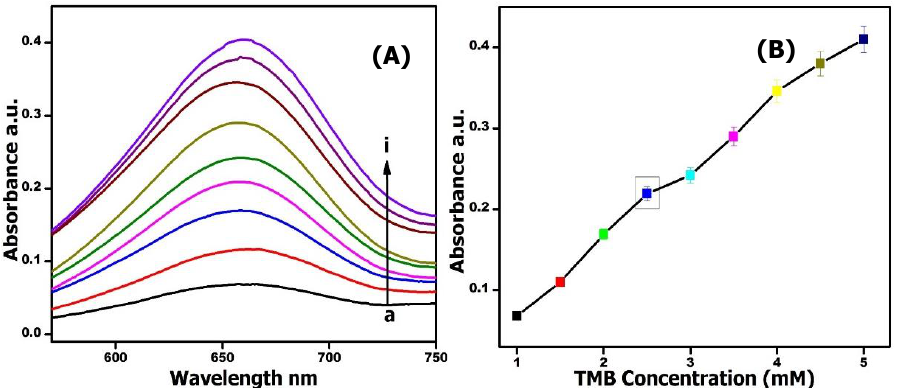
Figure 10. ( A ) Optimization of varying concentrations of TMB: (a) 1 mM (b) 1.5 mM (c) 2 mM (d) 2.5 mM (e) 3 mM (f) 3.5 mM (g) 4 mM (h) 4.5 mM (i) 5 mM ( B ) calibration plot of varying concentrations of TMB from (a) to (i). Error bars show the standard deviation from three parallel measurements.